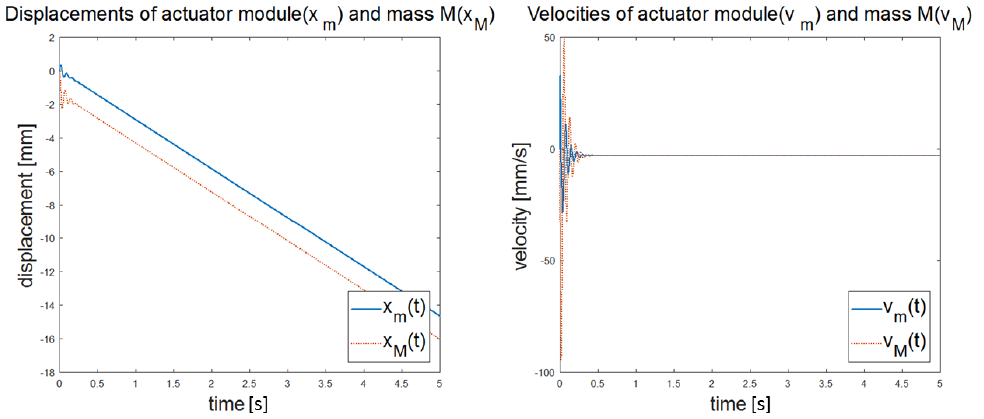
Figure 10. Displacement ( x m , x M ) and velocity ( v m , v M ) plots of the HSAM and the wire-attached mass M under Ω = 160 rev/s and M = 110 g.